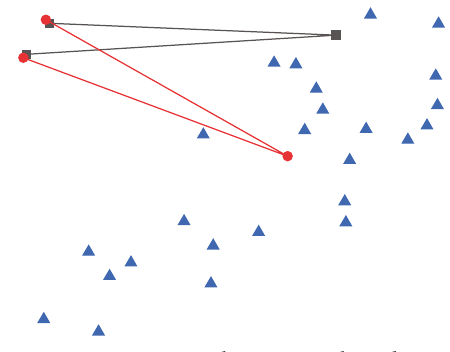
Figure 8: Community clustering analysis diagram.